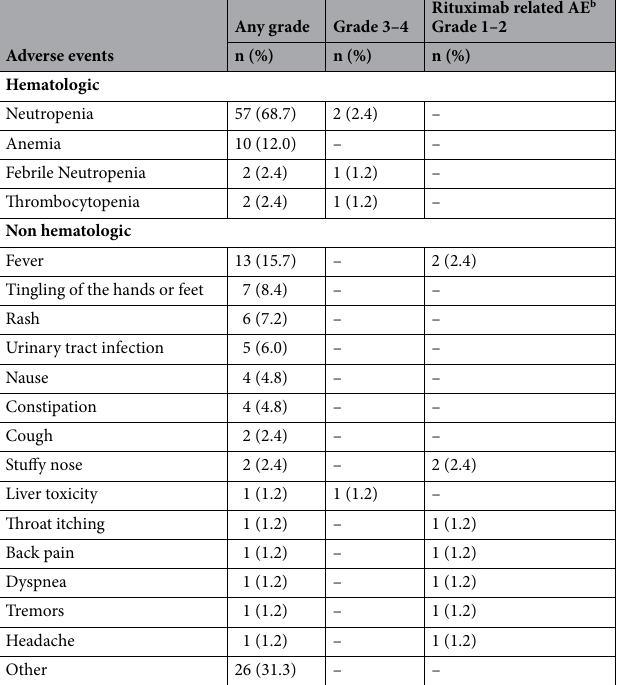
Table 2. Hematologic and non-hematologic adverse events registered during the study period a (March 2018- March 2019). N number. a Events experienced by at least two patients, or grade 3–4, or causally related to rituximab, are reported in the table. b The events were assessed as causally related to rituximab by the attending